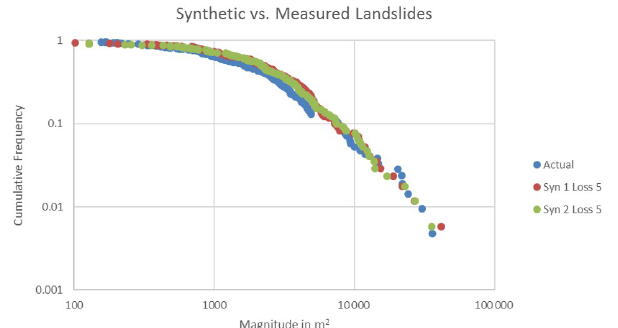
Figure 12. Cumulative magnitude–frequency comparison between mapped and modeled landslides (two